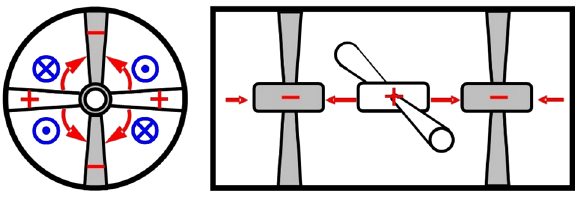
FIG. 21. Schematic diagram of a crossbar H -mode structure (CH) showing the electric fields in red and the magnetic fields in blue (courtesy of Rudolf